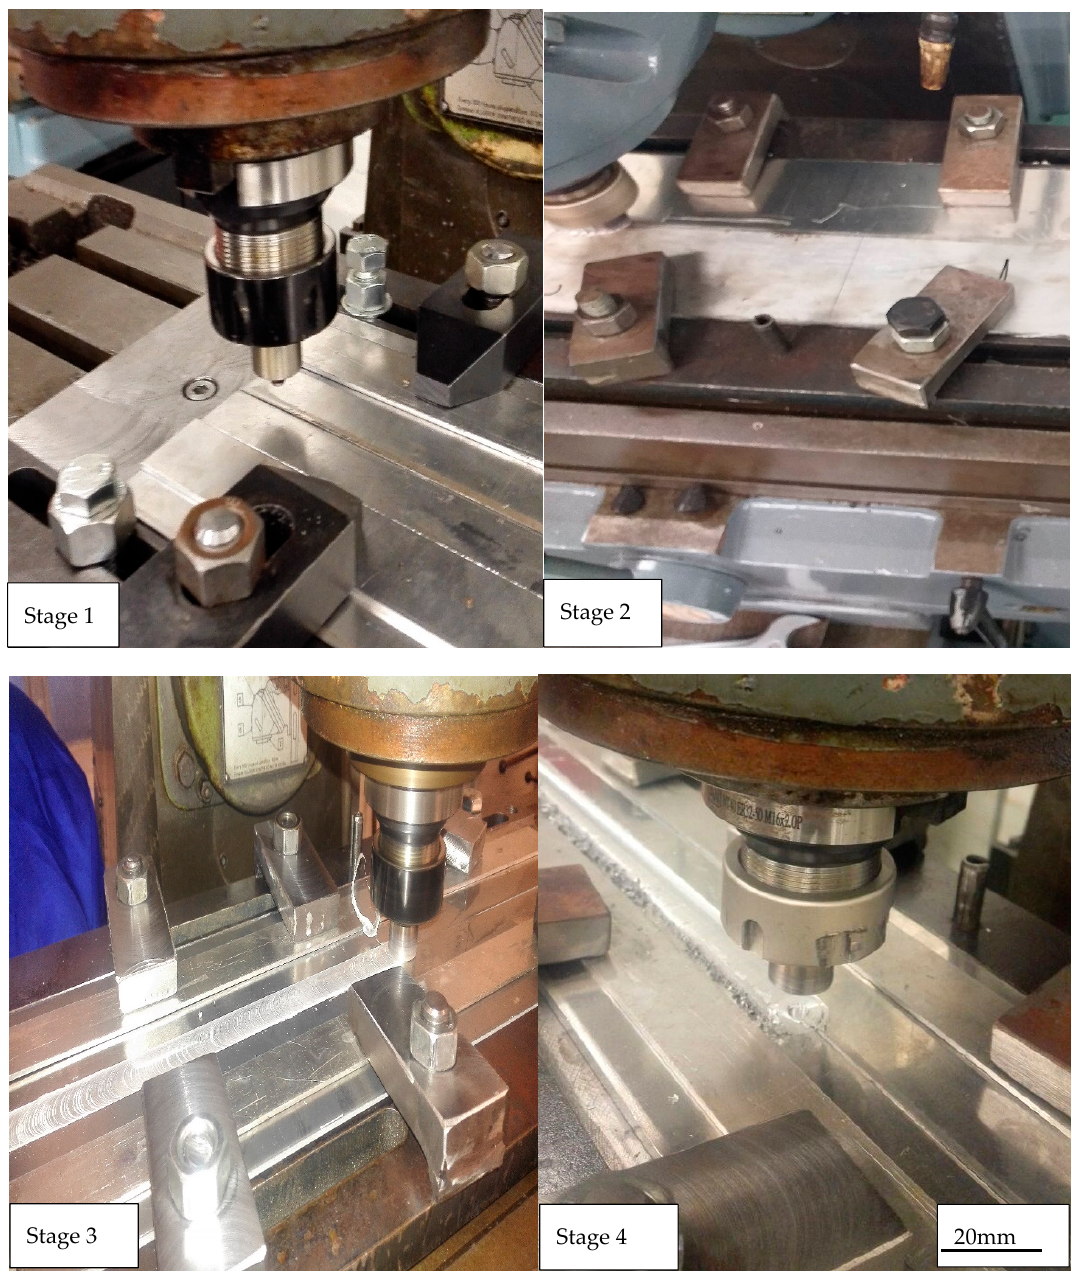
Figure 4. Friction stir welding process.